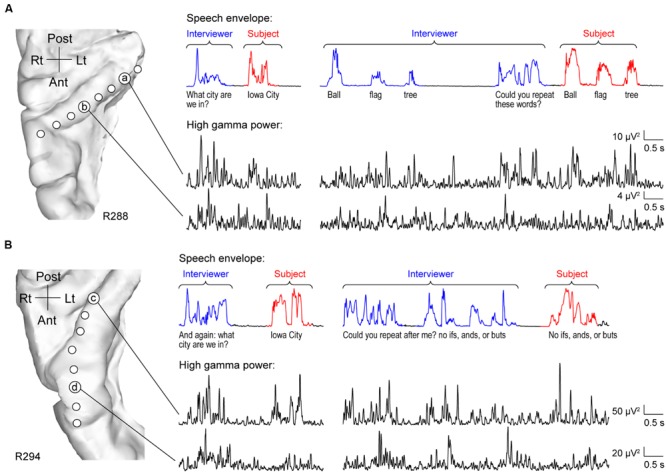
Activity in HG during performance of MMSE. (A) Exemplary data from subject R288. Left panel: MRI top-down view of right superior temporal plane showing the locations of recording contacts chronically implanted in HG. Right panel: speech envelopes of excerpts of the conversation, with interviewer’s and subject’s utterances highlighted in blue and red, respectively (top) and simultaneously recorded high gamma power from two representative sites in posteromedial and anterolateral HG (a and b, respectively; bottom). The transcript of the conversation is shown immediately below the speech envelopes. (B) Exemplary data from subject R294. Panels are arranged in the same way as in (A).